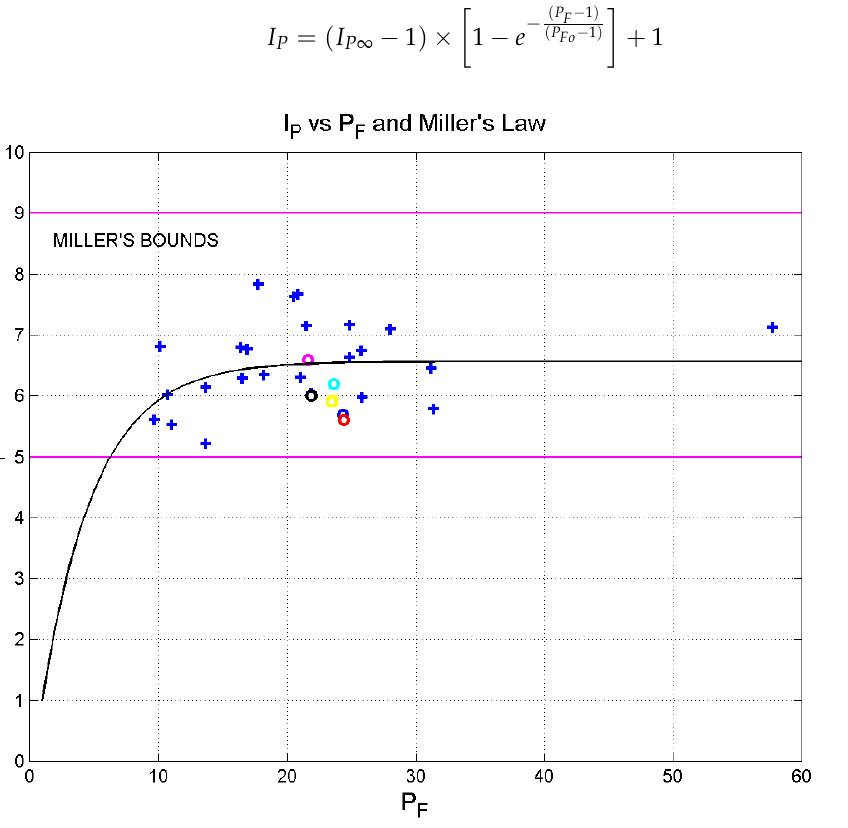
Figure 1. Scatter plot between 𝐼 𝑝 and 𝑃 𝐹 of the literary works of Tables 1 and 2, together with the non-linear regression line (best-fit line) that models, on average, 𝐼 𝑝 versus 𝑃 𝐹 for these works, Equation (1), and Miller’s bounds. Dickens’ novels are represented by the circles: The Adventures of Oliver Twist , blue; David Copperfield , red; Bleak House , magenta; A Tale of Two Cities , cyan; Our Mutual Friend , black. Matthew : yellow square. The blue crosses refer to the other works listed in Table 2. The mark on the far right refers to Robinson Crusoe .